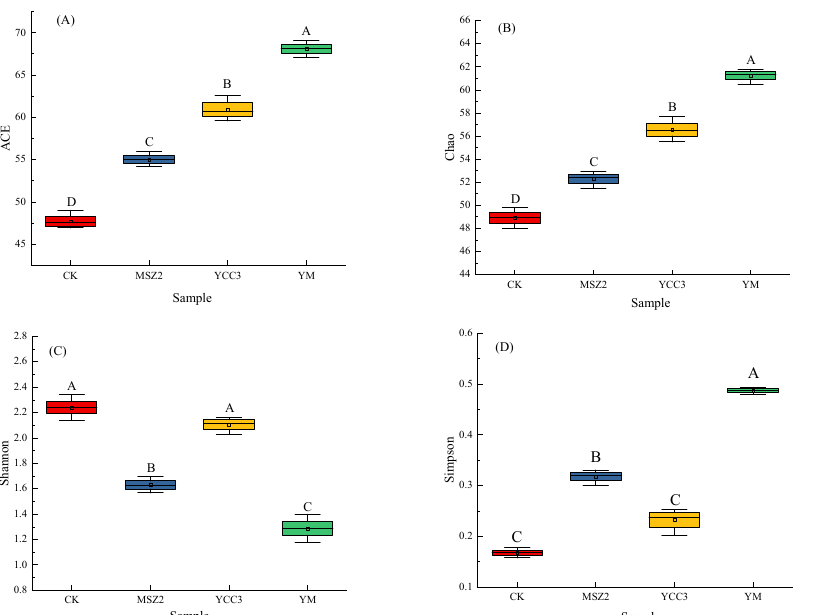
Figure 1. Alpha diversity in fermented sausages. Alpha diversity indexes include bacterial richness indexes (consisting of ACE and Chao 1) and bacterial diversity indexes (composed of Shannon and Simpson indexes). ( A ): ACE indexes. ( B ): Chao 1 indexes. ( C ): Shannon indexes. ( D ): Simpson indexes. CK group is red, MSZ2 group is blue, YCC3 group is yellow and YM group is green. Different letters indicate significant differences ( p < 0.05).